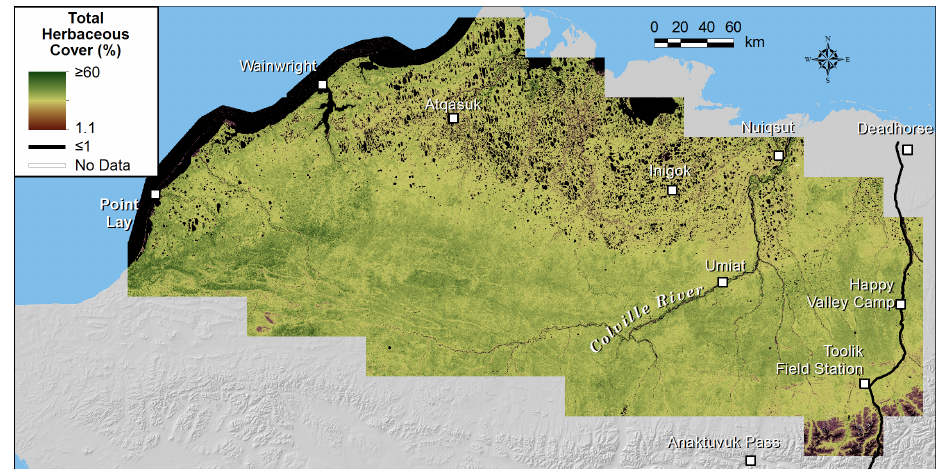
eolian sand sheet region of the coastal plain, where this PFT is common, except in wet areas.